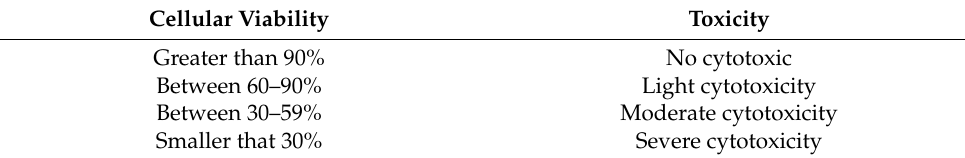
Table 12. Toxicity